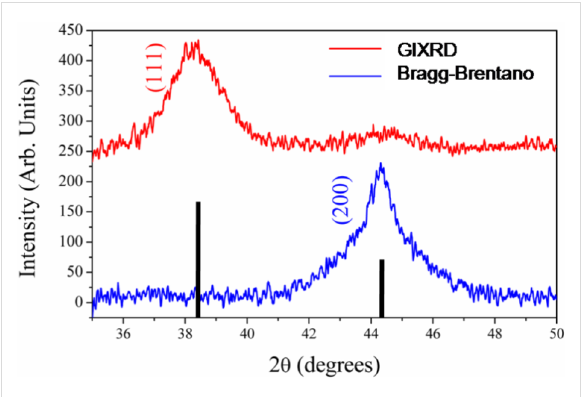
for 70 s. The more discernible effect is a pronounced change in the fractional covered area that varies by about 15%. By using a STEM detector with a large inner radius (a HAADF detector) electrons are collected which are not Bragg scattered. As such HAADF images show little or no diffraction effects, and their intensity is approximately proportional to Z 2 . The HF postdepo- sition treatment levels off the intensity distribution of the corre- sponding STEM micrograph, indicating a more uniform thick- ness for the gold particles as clearly seen by comparing Figure 4c and Figure 4d, respectively.